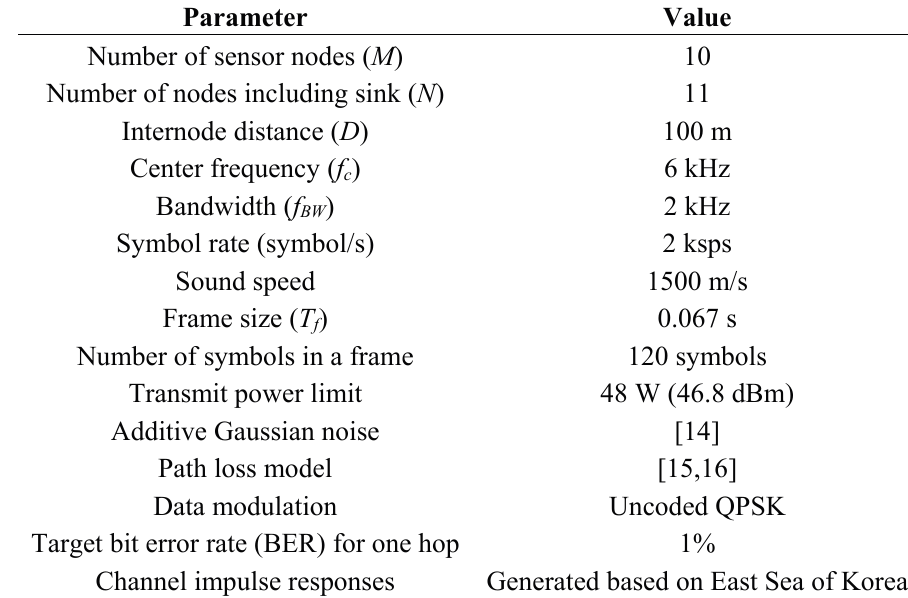
Table 1. Simulation